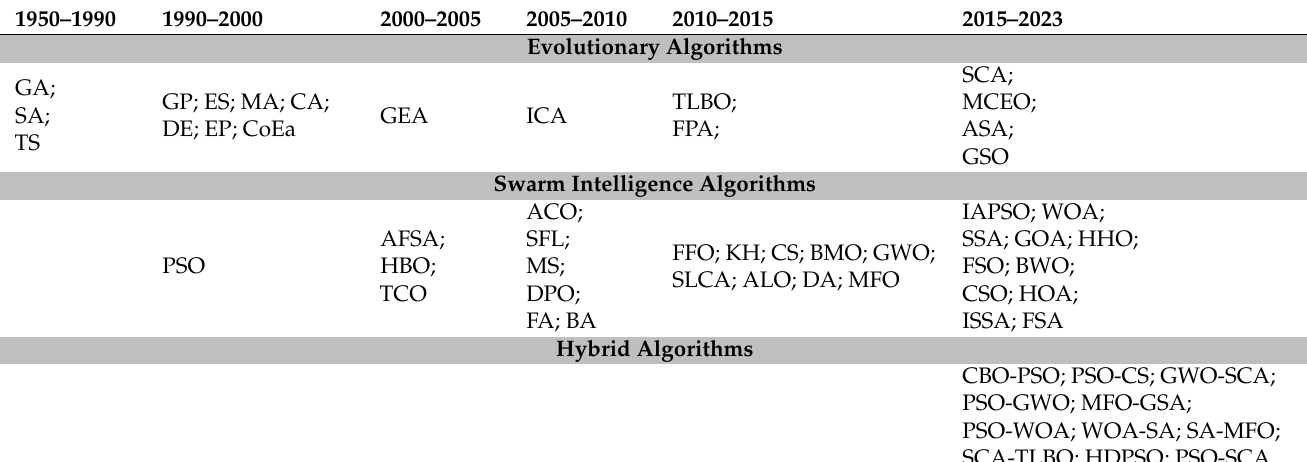
Table 14. Development year of optimization algorithms.